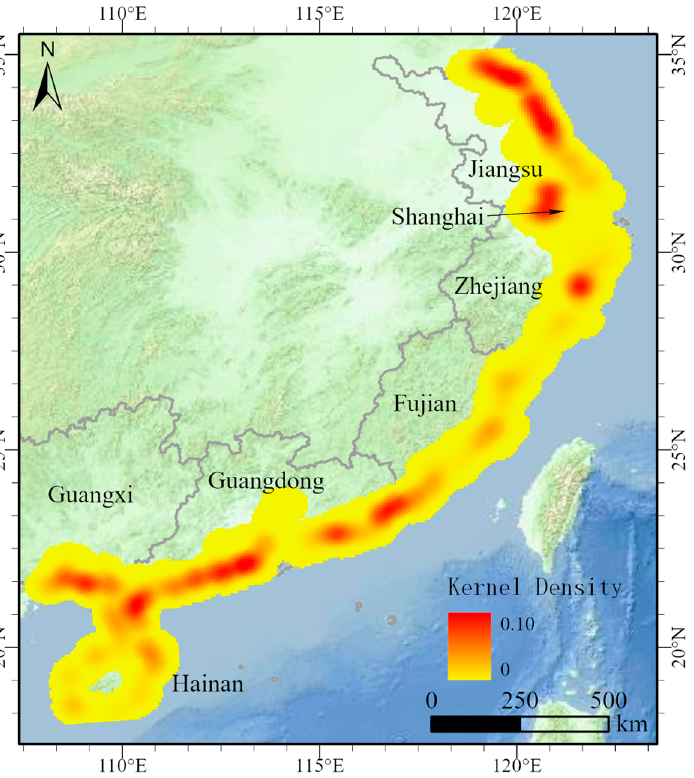
Figure 13. Kernel density analysis of the aquaculture pond region in coastal waters of the southeast region.